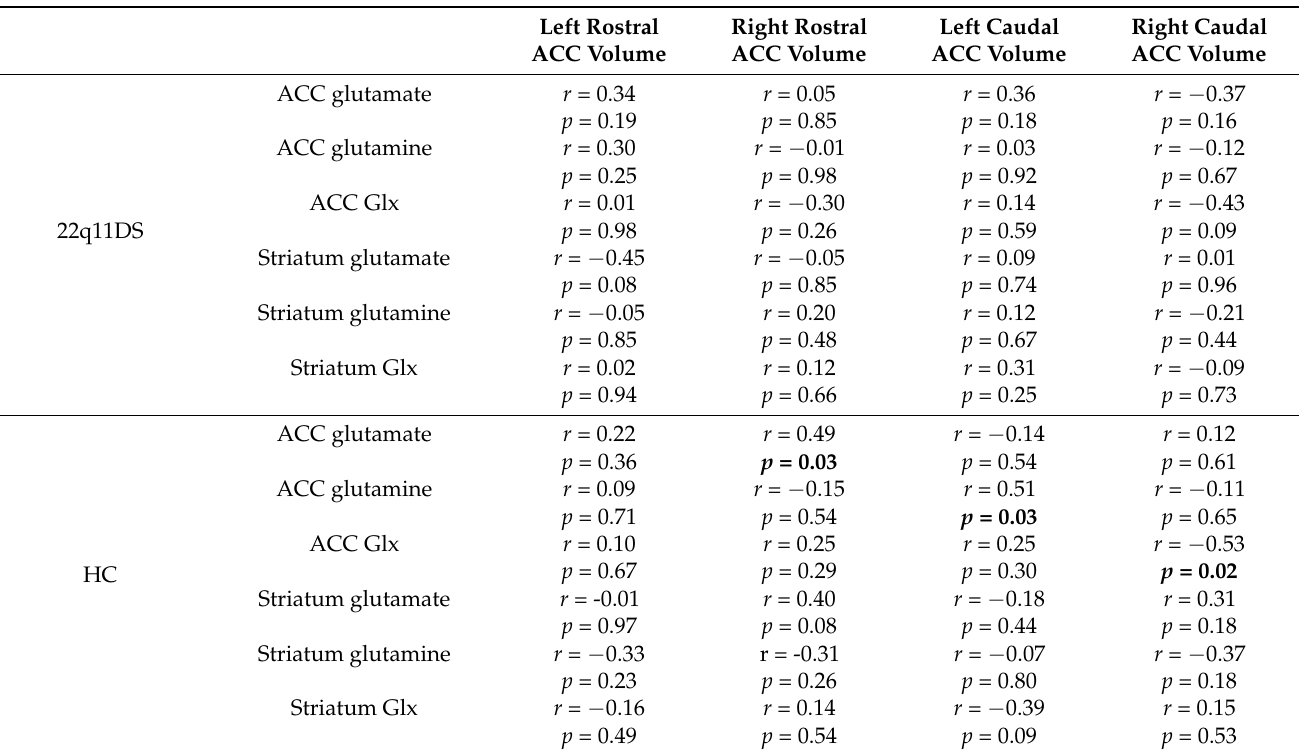
Table 3. Associations between glutamatergic functioning and ACC volumes in 22q11DS and healthy controls 1 . Left Rostral Right Rostral Left Caudal Right Caudal ACC Volume ACC Volume ACC Volume ACC